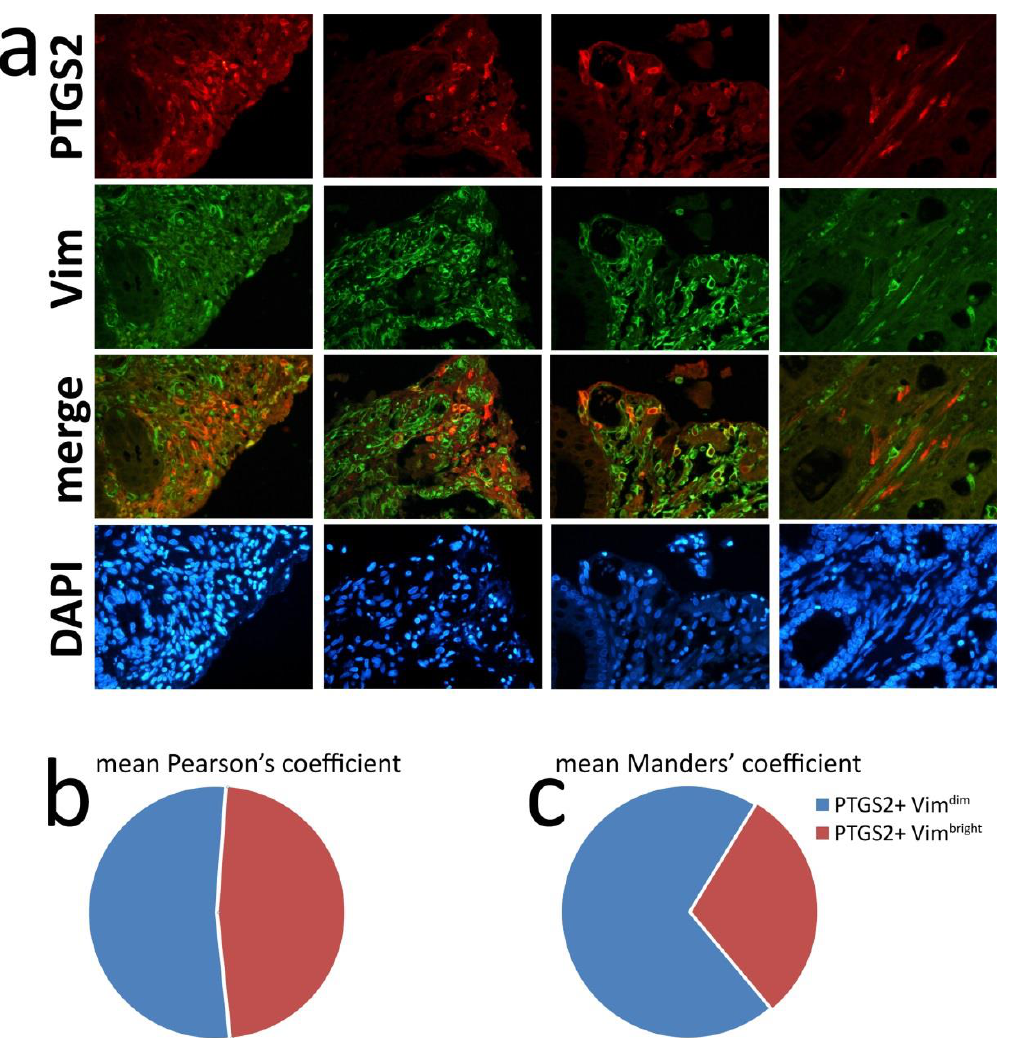
Figure 5. Immunofluorescent double staining of PTGS2 and vimentin indicates cancer-associated fibroblasts as a major source of PTGS2: ( a ) Representative images of PTGS2 and vimentin double immunofluorescence in four CRC. PTGS2 positivity almost invariably corresponded to vimentin positive cells, although bright PTGS2 staining frequently corresponded to dim vimentin staining and vice versa; ( b ) mean PTGS2 – vimentin co-localization evaluated by Pearson's coefficient after the subtraction of dim vimentin positivity; ( c ) mean Manders' overlap coefficient evaluating the extent of PTGS2 signal in bright vimentin-positive areas (complete analysis is shown in Supplementary Figure S3).